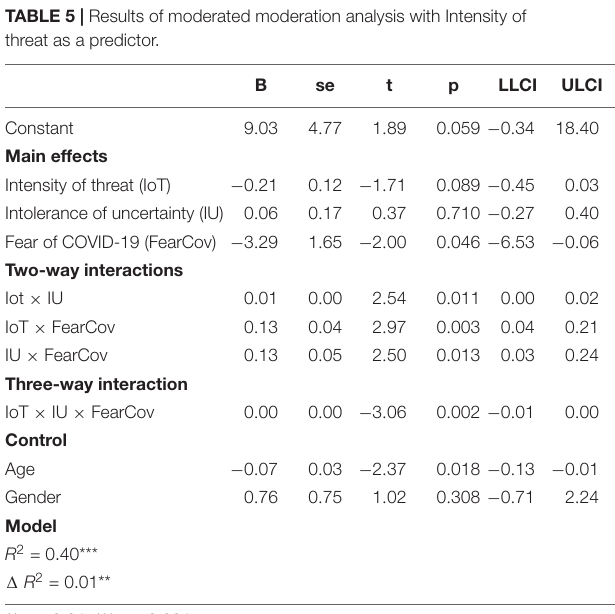
TABLE 5 | Results of moderated moderation analysis with Intensity of threat as a